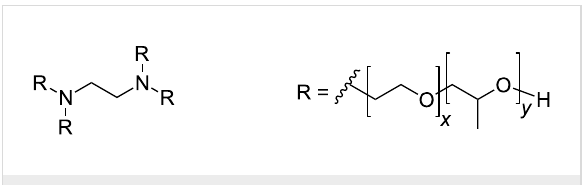
Figure 6: Chemical structure of a reverse Tetronic.